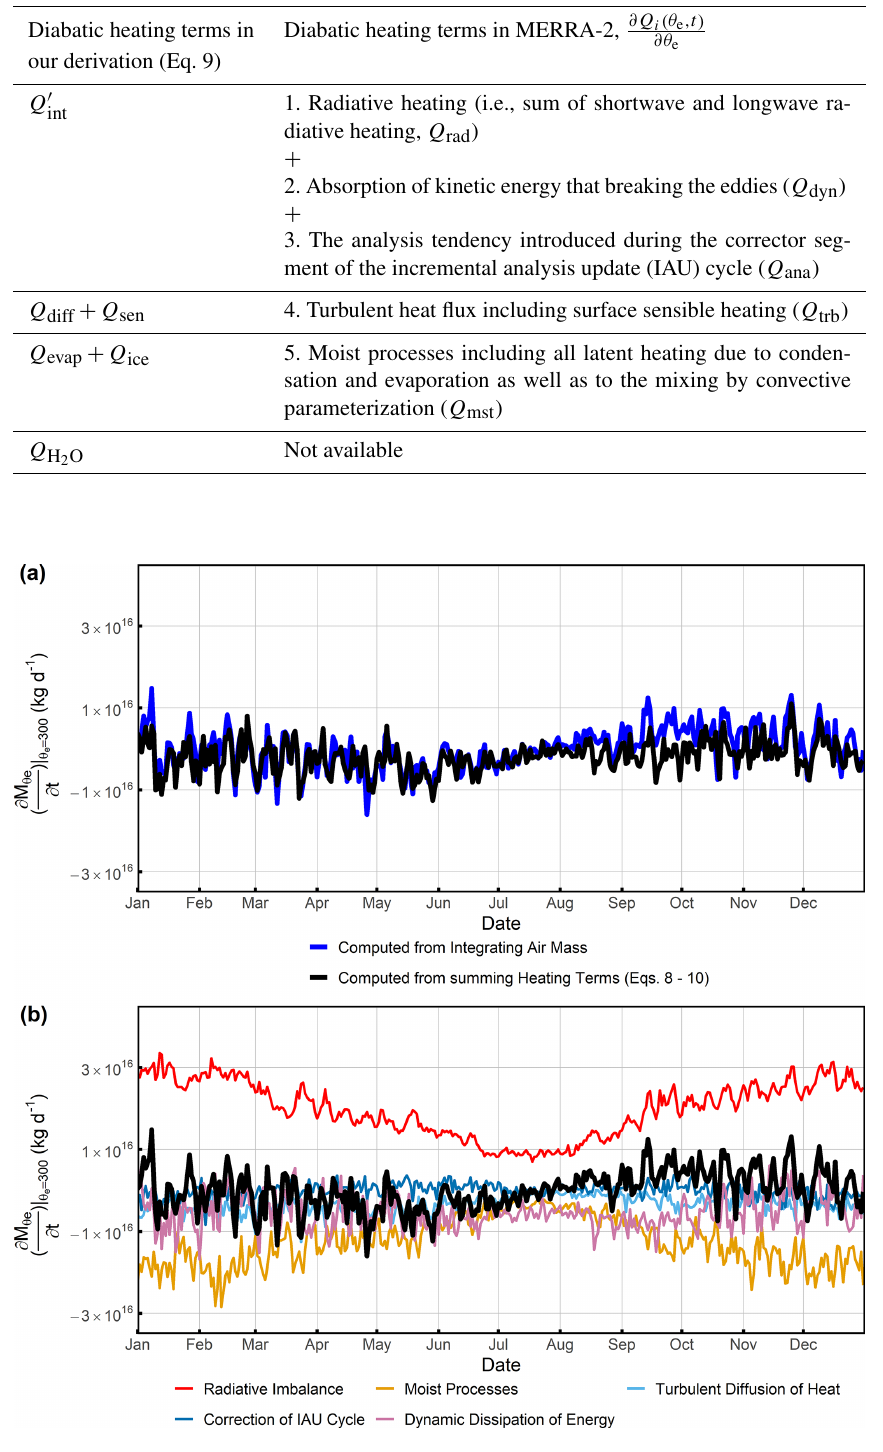
Figure 7. (a) Temporal variation in M θ in the Northern Hemisphere at θ e = 300K computed by integrating air mass (blue line) and estimated e from the sum of five heating terms (Table 1) in MERRA-2 (black line). (b) The heating variables are decomposed into five contributions as indicated (see Table 1). Results shown are for the year